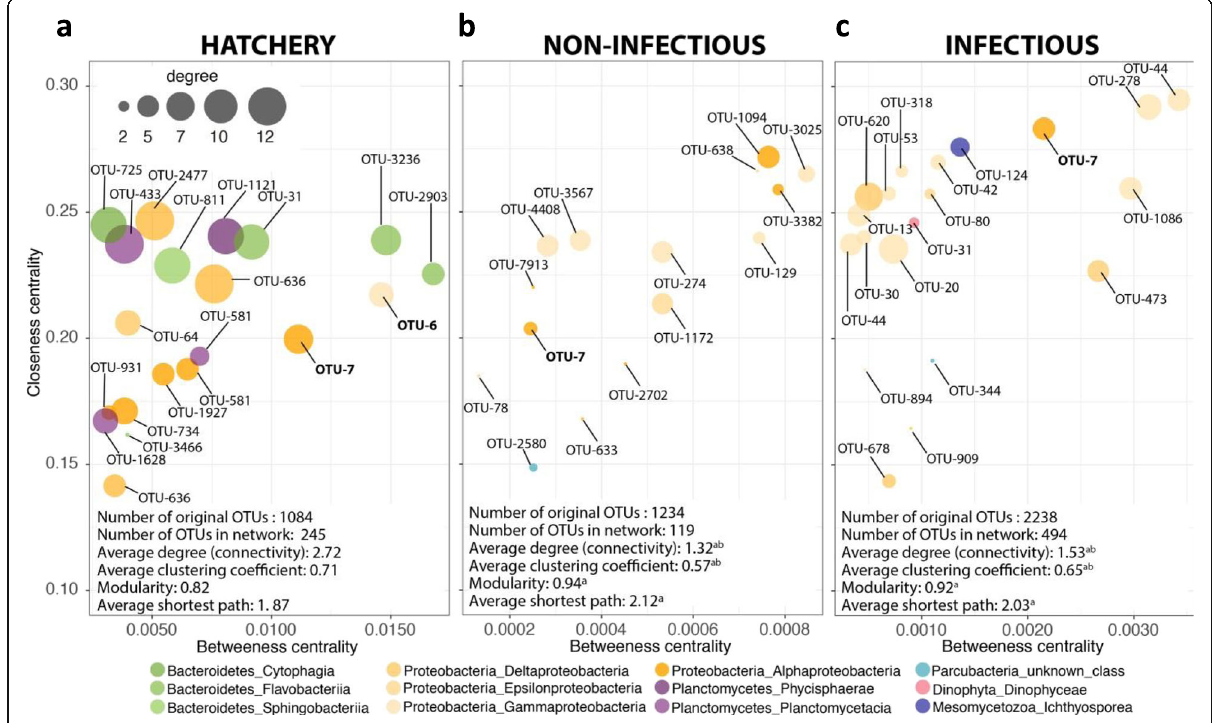
Fig. 6 Relationship between closeness and betweenness centrality values for microbial co-occurrence networks in controlled and natural conditions. The plots show closeness vs. betweeness centrality values for nodes in the hatchery ( a ), non-infectious ( b ) and infectious ( c ) networks based on bacterial and protist OTUs. Only the 20 nodes with the highest degree value are represented for each network. Color indicates phylum or class-level taxonomic assignment of the nodes. General network properties are specified in the lower left corner of each plot. A superscript ‘ a ’ indicates a significant difference ( p < 0.01) between the hatchery and infectious or non-infectious general network properties. A superscript ‘ b ’ indicates a significant difference ( p < 0.01) between infectious and non-infectious general network